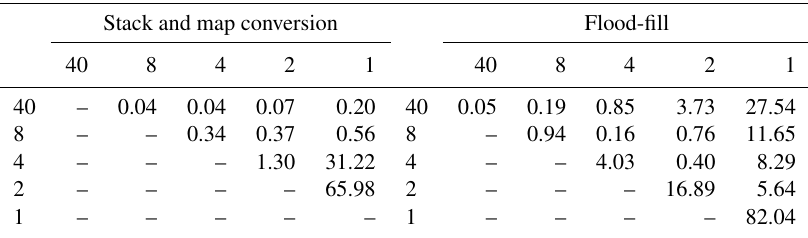
Table 1. Computation time in seconds for stack and map conversion between different resolutions and for flood-filling at different resolutions with different starting stacks, for the 40, 8, 4, 2 and 1km series. The yellow shaded numbers are explained in the text. Stack and map conversion